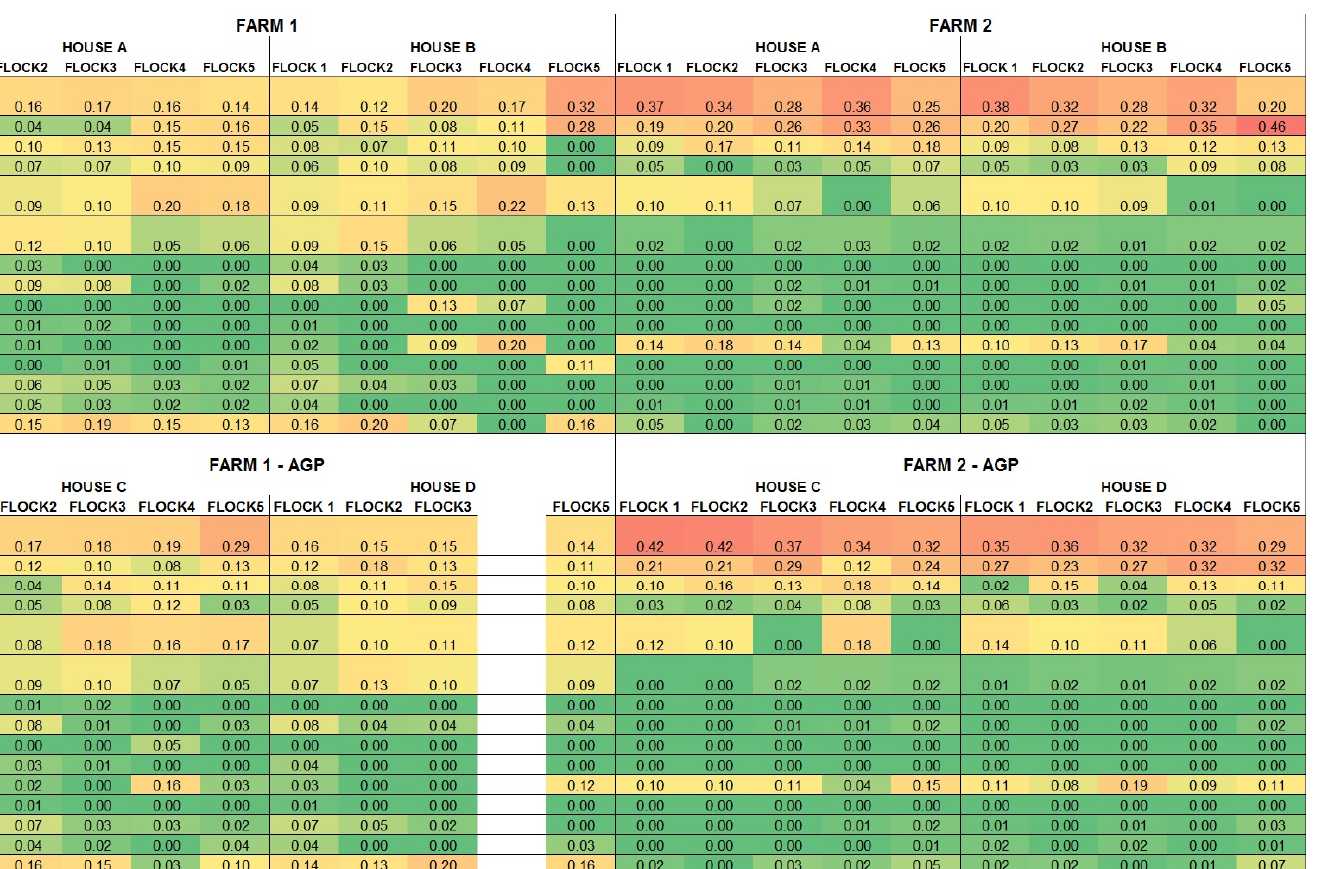
Figure 1. Abundance of T-RFLP peaks contributing greater than 2% of total 16S rRNA signal of litter from 5 sequential flocks of broiler chickens reared on commercial poultry farms. Two houses (C and D) on each farm contained birds that were fed antibiotic growth promoters (AGP); houses A and B were fed no antibiotics. The results are shown as the proportion of total T-RFLP signal for each flock using a green → red gradient